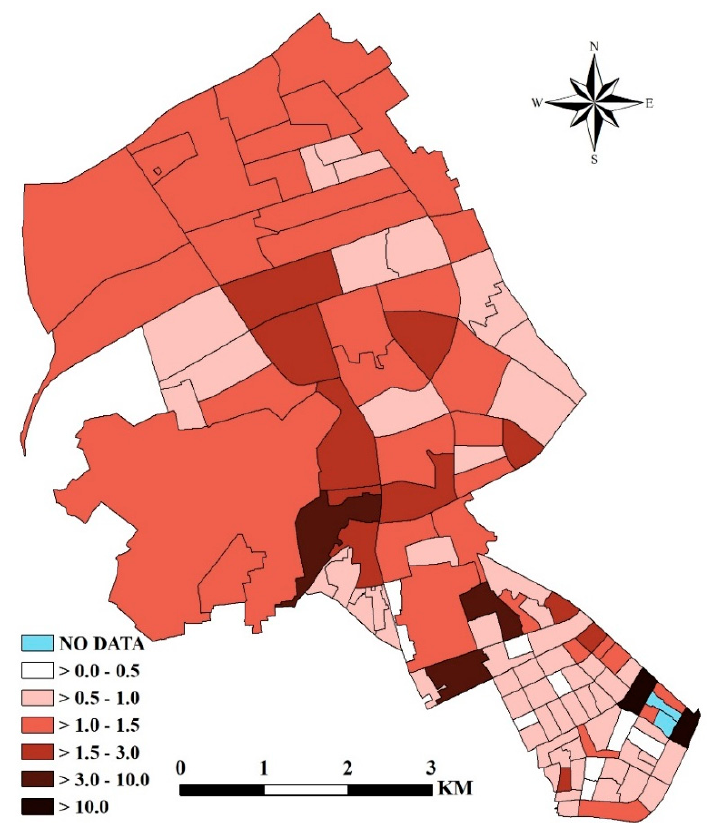
Figure 3. Burglary risks due to independent variables.